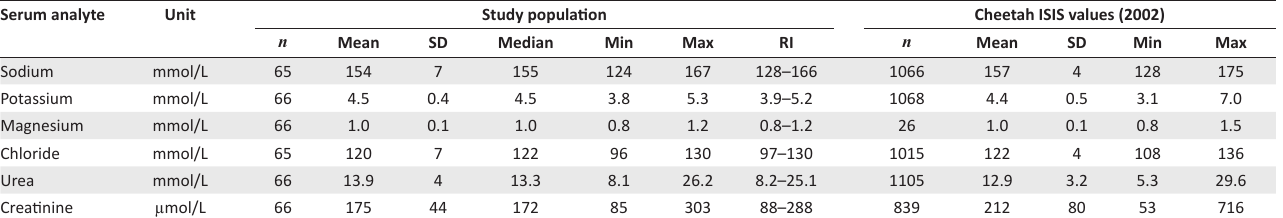
TABLE 3: Reference intervals for six serum analytes in Namibian cheetahs in the present study and ISIS values for all cheetahs. Serum analyte